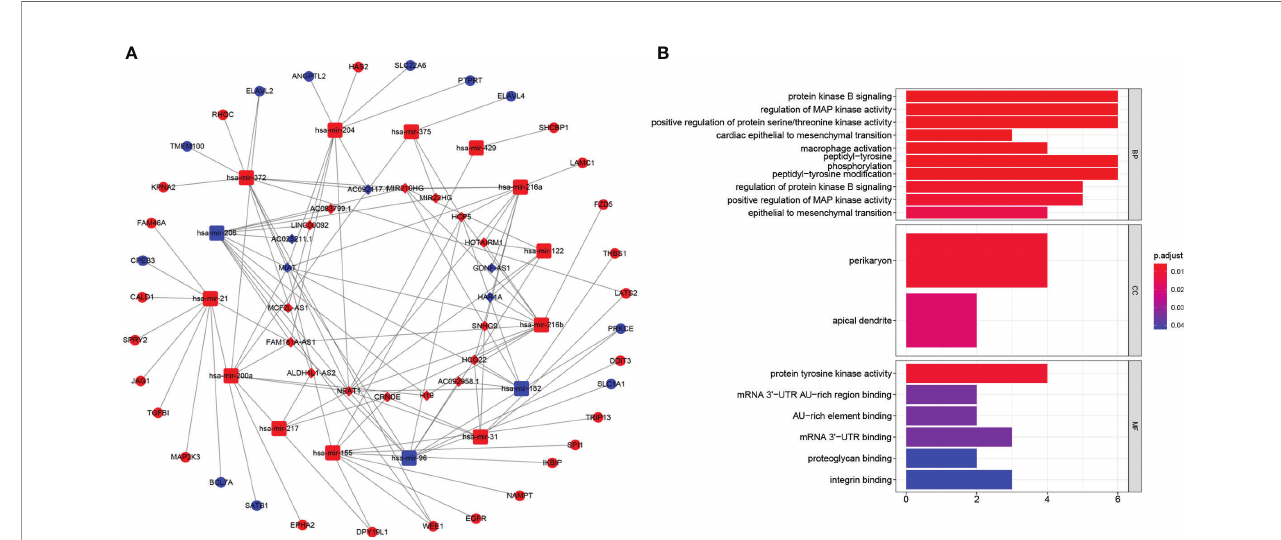
FIGURE 8 | (A) The ceRNA network of the seven pyroptosis-related lncRNAs (rhombus) and their target miRNAs (quadratee) and mRNAs (circle). (B) Bar plot showed that functional enrichment of targeted mRNA in the